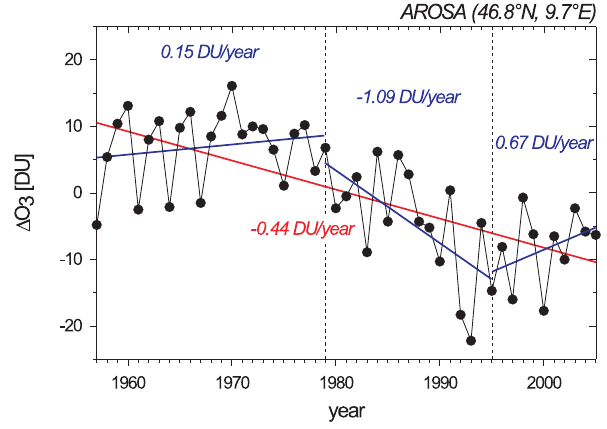
Fig. 11. Long-term variation of total ozone observed at Arosa after elimination of the solar and geomagnetic influences. The red line is the linear trend for the whole interval between 1957 and 2005, the blue lines characterize the trends in different sub-intervals.